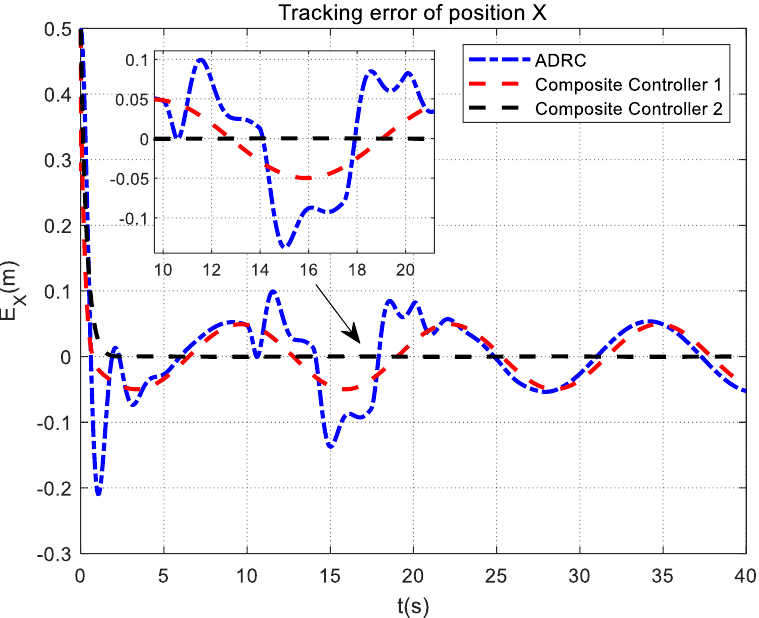
Figure 12. Tracking error of position X control for QUAV under actuator constant fault and distur‑ bance condition.